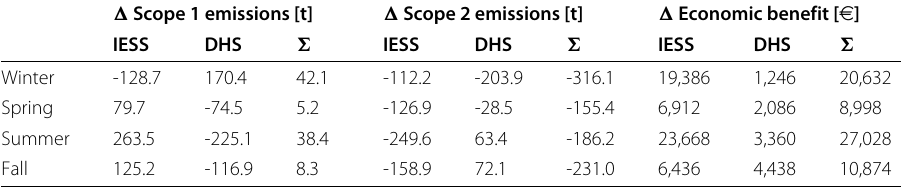
Table 1 Simulation results: changes in emissions and economic benefit between baseline and optimized